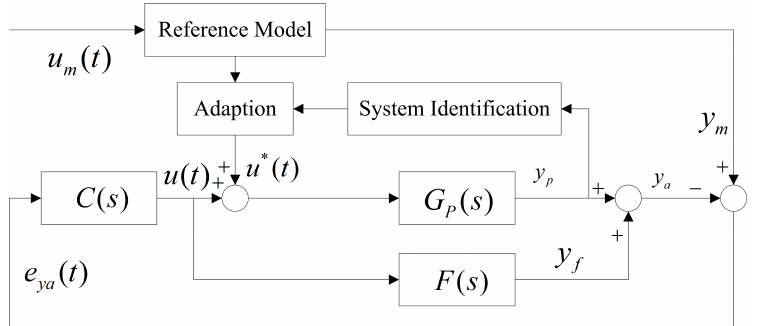
Figure 6. Adaptive output following control based on identification